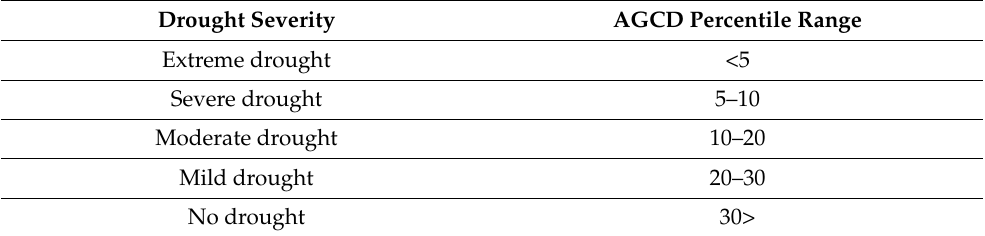
Table 3. The relationship between drought severity and AGCD percentile values. Drought Severity